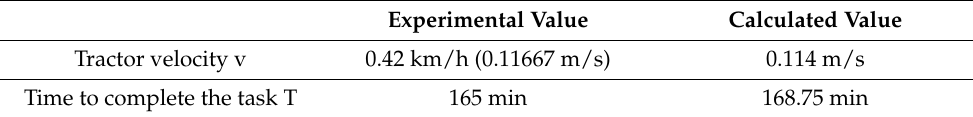
Table 1. Comparison between experimental and calculated values.